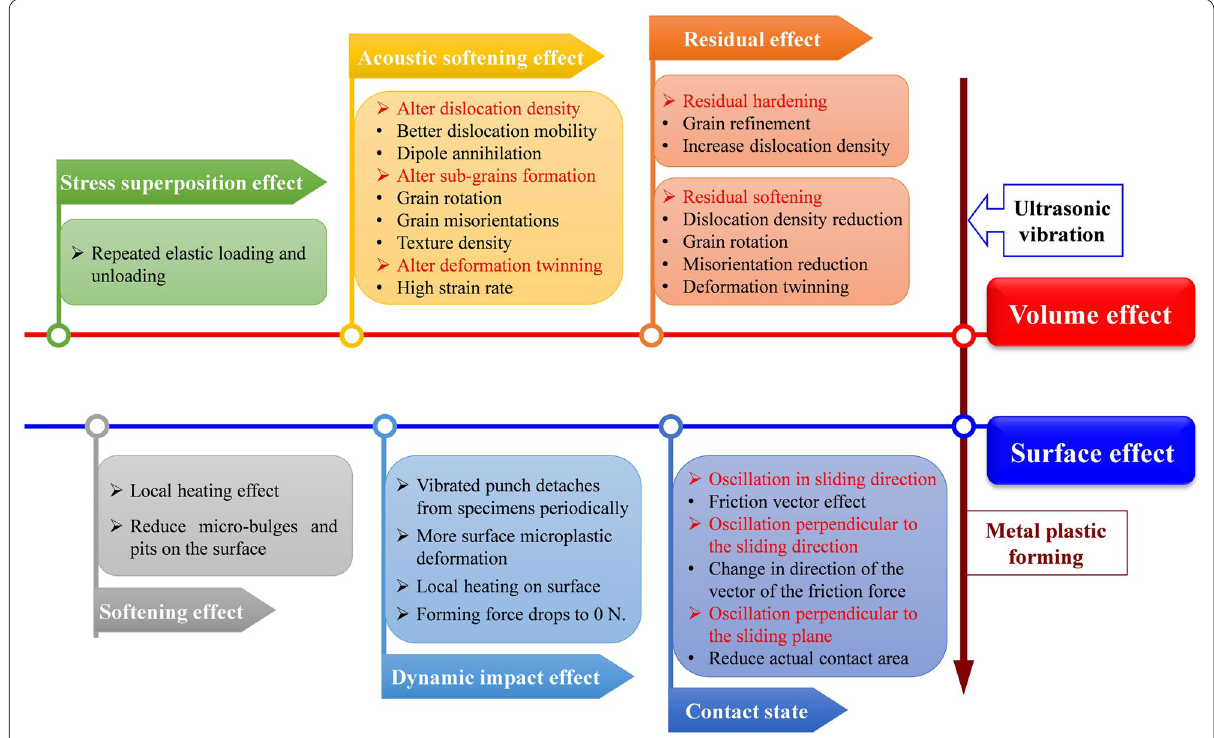
Figure 6 Schematic diagram of ultrasonic-assisted forming